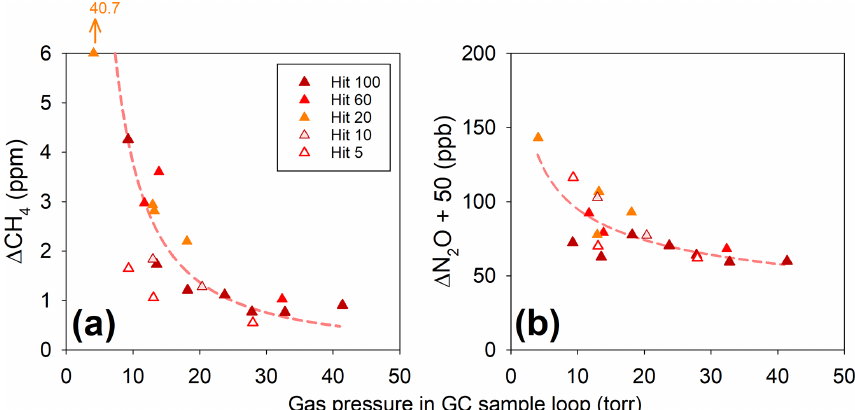
Figure A2. Influence of different amounts of hitting on the systematic blank of the needle crushing (dry extraction) system for (a) CH 4 and (b) N 2 O measurements. Note that all data are plotted against the amount of gas trapped in the sample tube, presented here as the pressure in the GC sample loop when the sample gas is expanded (see main text). The capital-delta ( (cid:49) ) notation on the y axes indicates the offset from the values of the standard